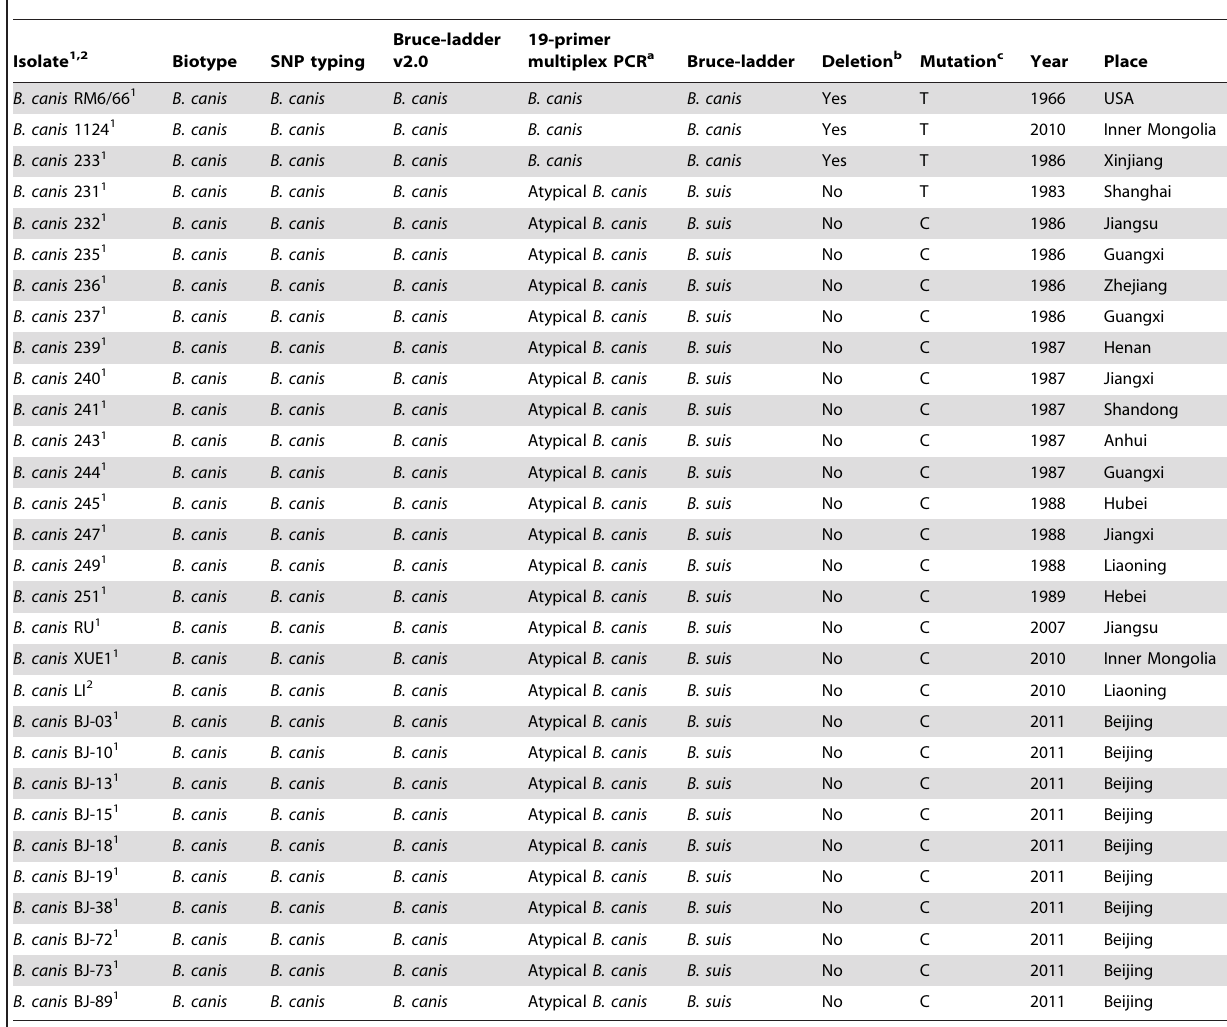
Table 1. Brucella canis isolates and characterization using different molecular typing methods.